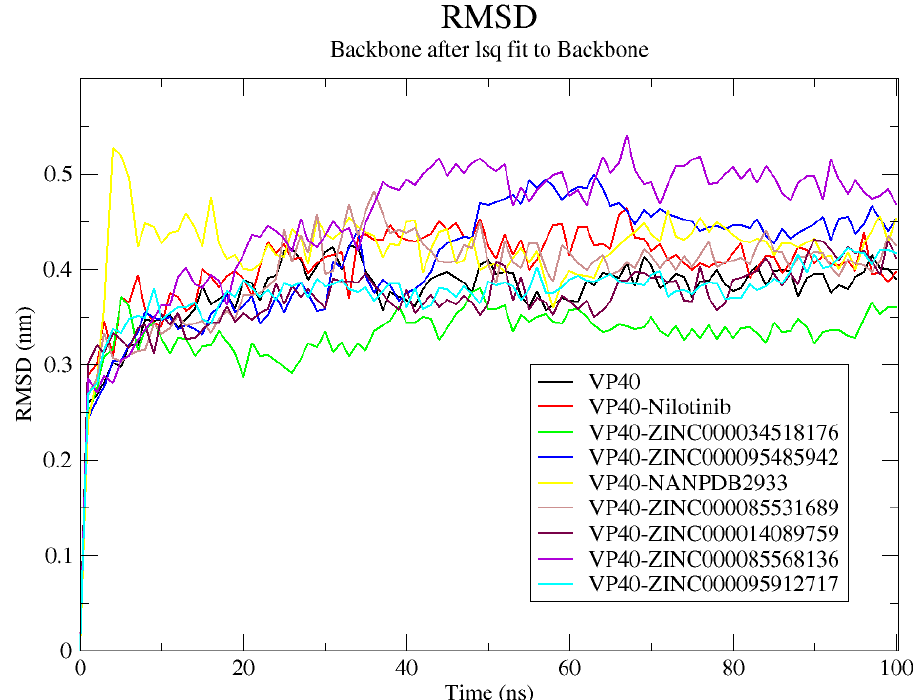
Figure 4. RMSD plot of the EBOV VP40 and VP40–ligand complexes after 100 ns MD